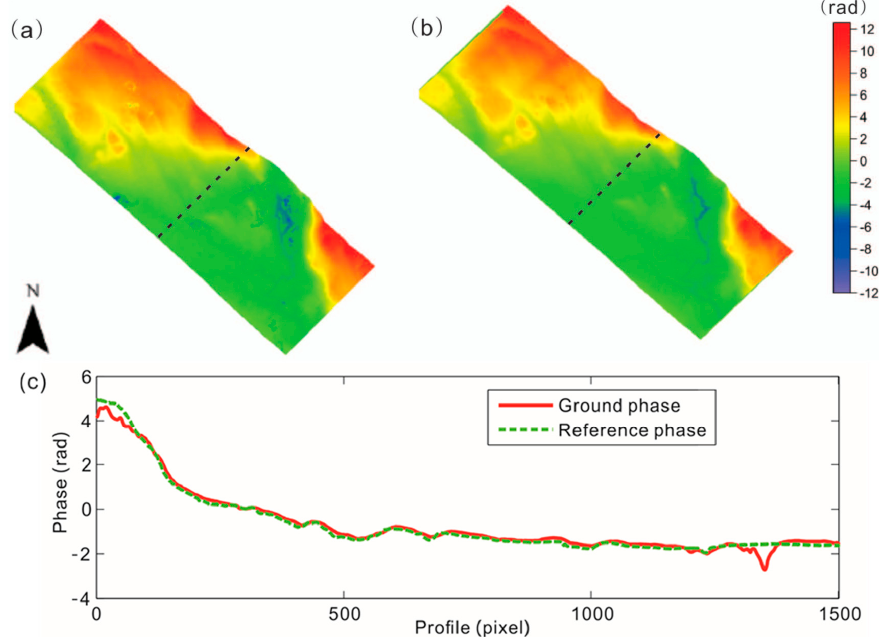
Figure 6. The ground phase ( a ); the reference phase ( b ) generated by LiDAR DEM which are unwrapped; and the contrast of the profiles ( c ) shown as the black dashed lines in ( a ) and ( b ).